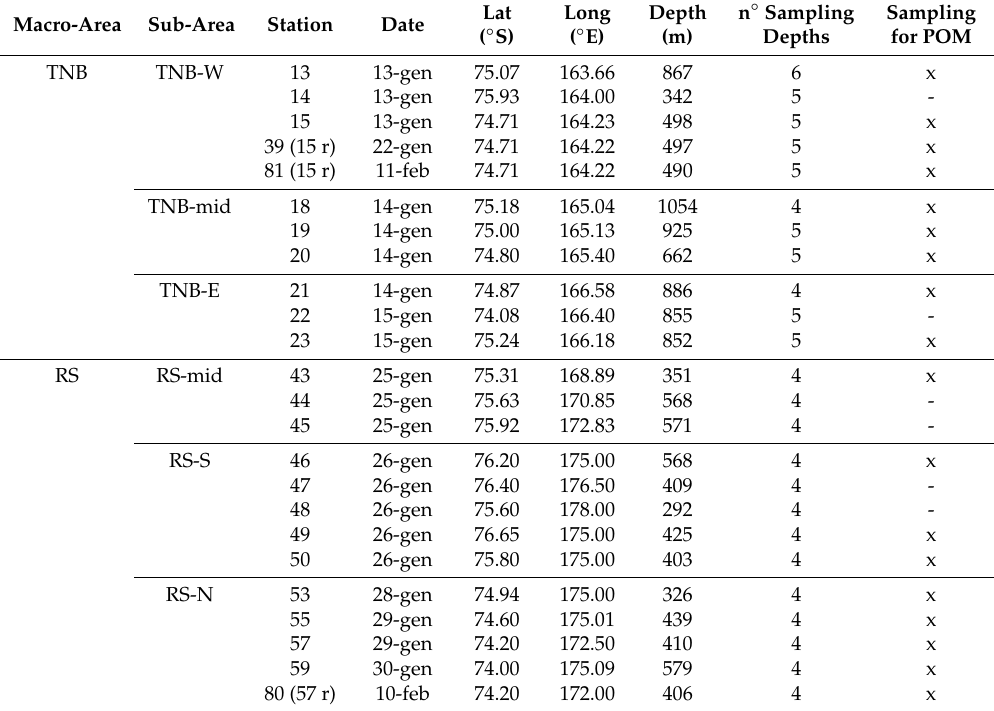
Table 1. Position and depth of the sampled stations and their grouping in the main macro-areas and